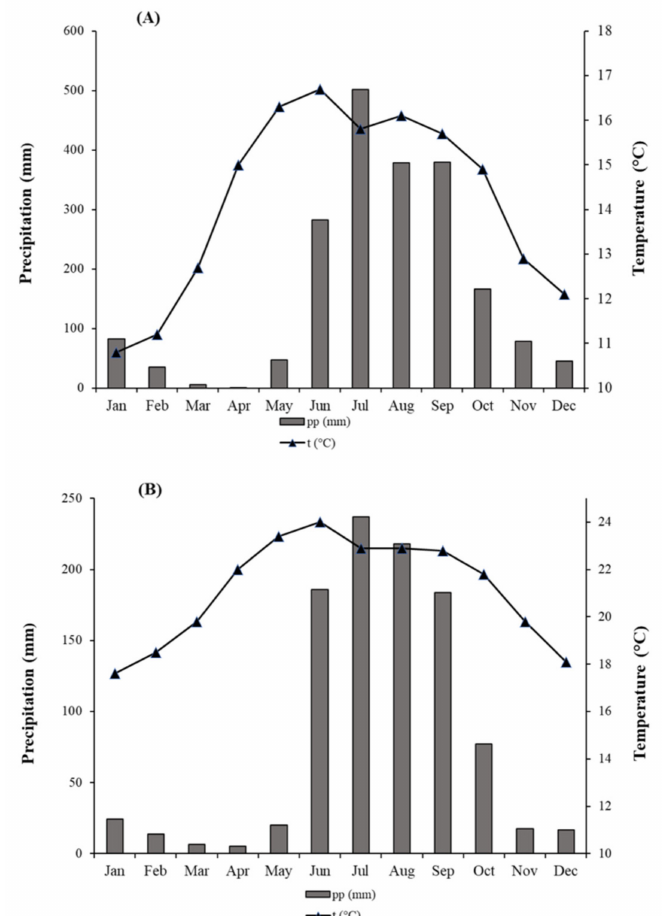
Figure 2. Climatic characteristics at meteorological stations: ( A ) = Cumbre de Guadalupe; ( B ) = Mascota (1961–2014). Average monthly temperature (black lines) and average total monthly precipitation (gray bars).